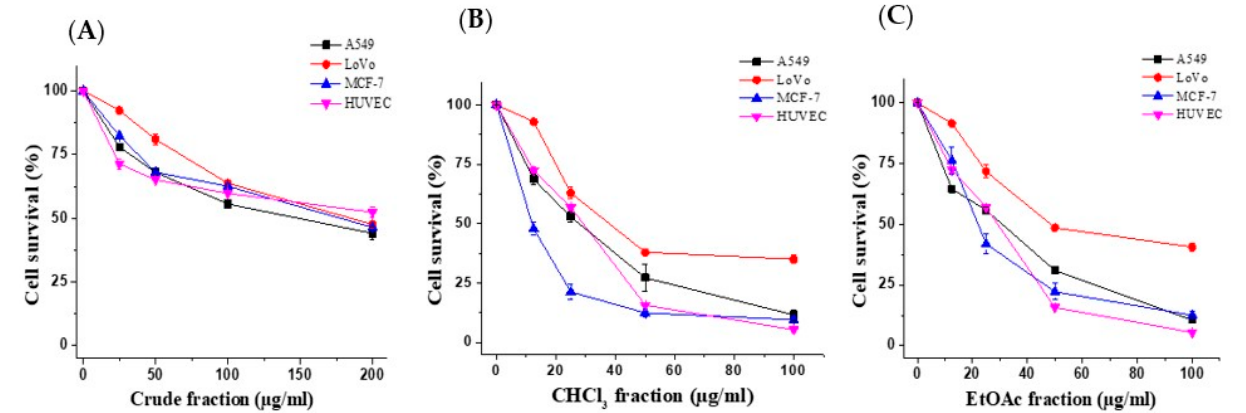
Figure 3. Cell viability of di ff erent cells following treatment with E. saudiarabica crude extract, CHCl 3 and EtOAc fractions. The cell viability was measured by MTT assay. Cells were treated with different concentrations of crude extract ( A ), CHCl 3 ( B ) or EtOAc ( C ) fractions. Data are presented as the mean ± standard deviation (SD) from three independent